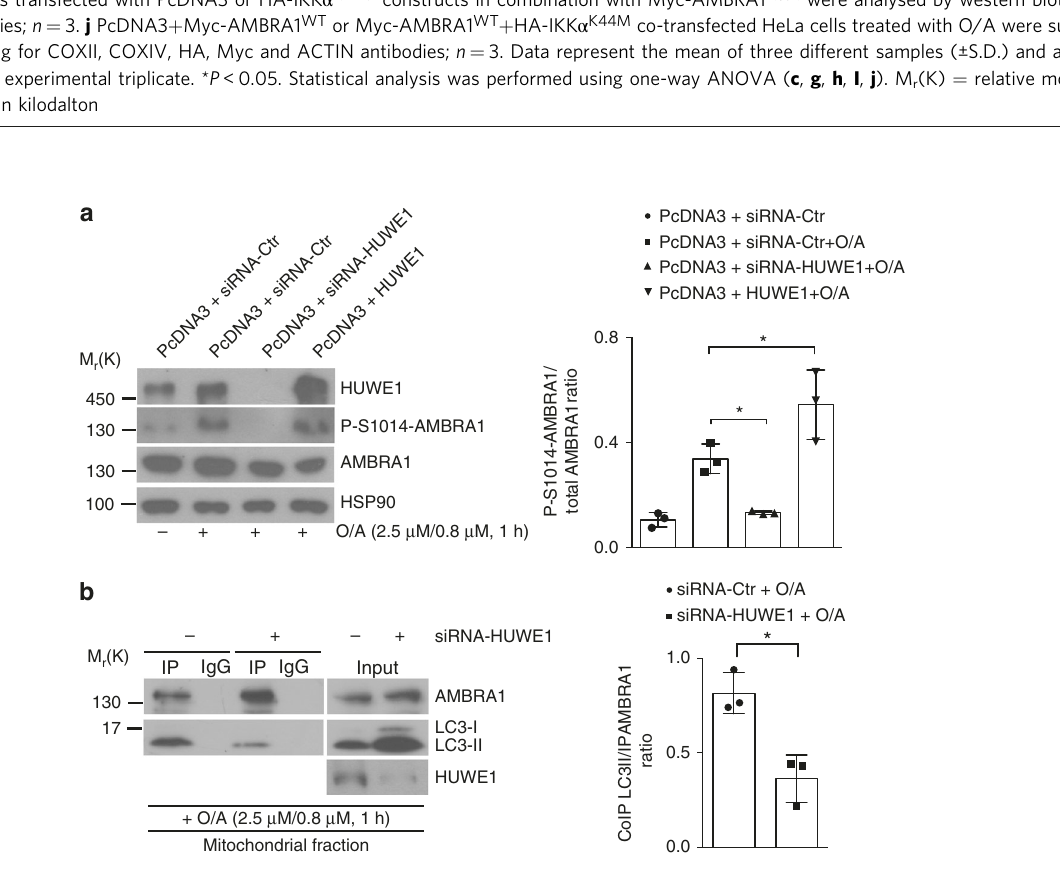
Fig. 5 IKK α controls AMBRA1 phosphorylation at S1014 during mitophagy. a Sequence alignment of the consensus sequence of IKK α -phosphorylation